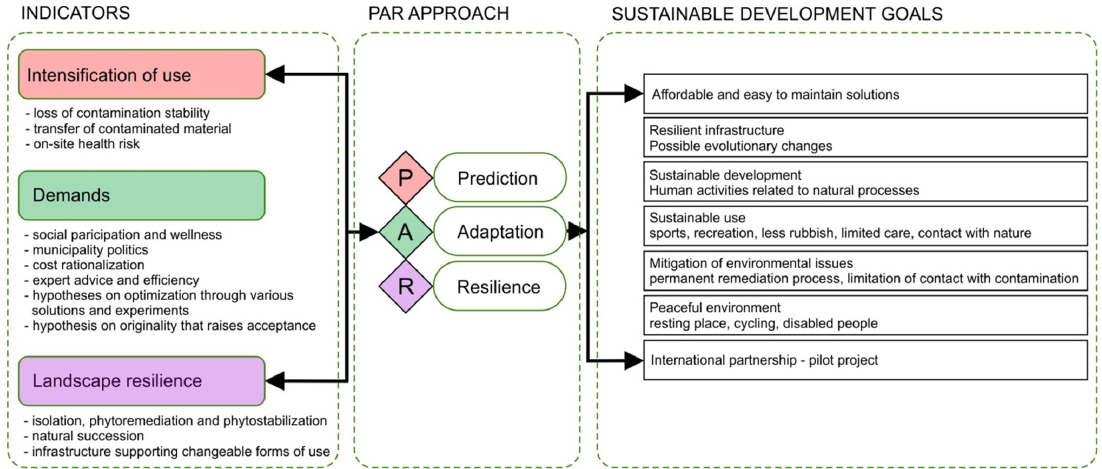
Figure 4. PAR approach concerning urban spatial growth [5] adapted for developing a contaminated spoil heap develop- ment.